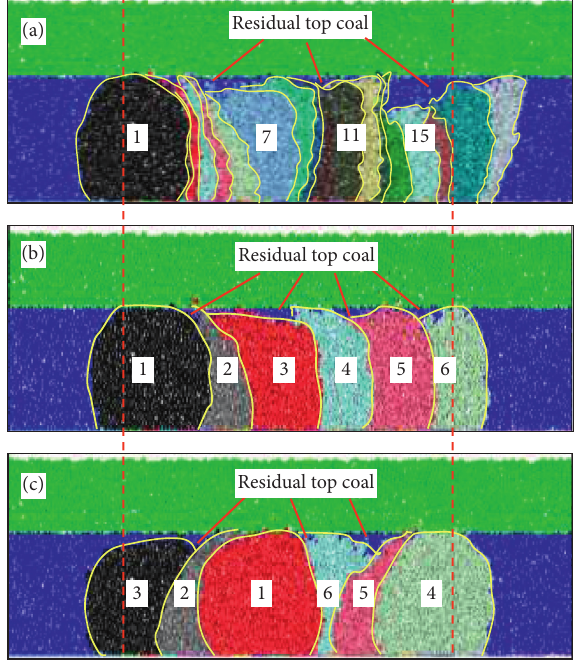
Figure 9: Drawing body shapes under (a) SOSCT, (b) MOSCT, and (c)